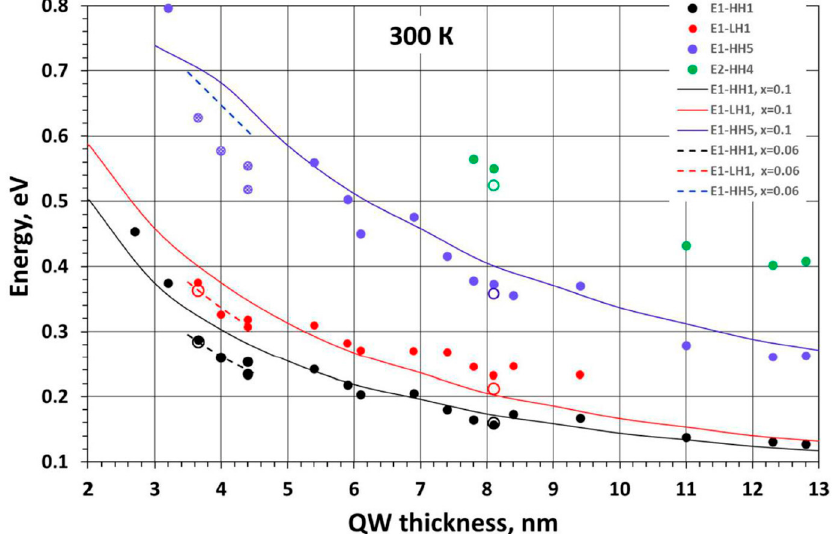
Figure 6. IBETE’s dependences on well width in MQWs. The solid and open circles are the experi- mental and calculated IBETEs values. The solid and dashed curves are the calculated data for MQWs with constant Cd composition x = 0.1 and x = 0.06: black curve–E1-HH1; red curve–E1-LH1, blue curve–E2-HH2. The green solid circles are for E2-HH4 IBETEs.